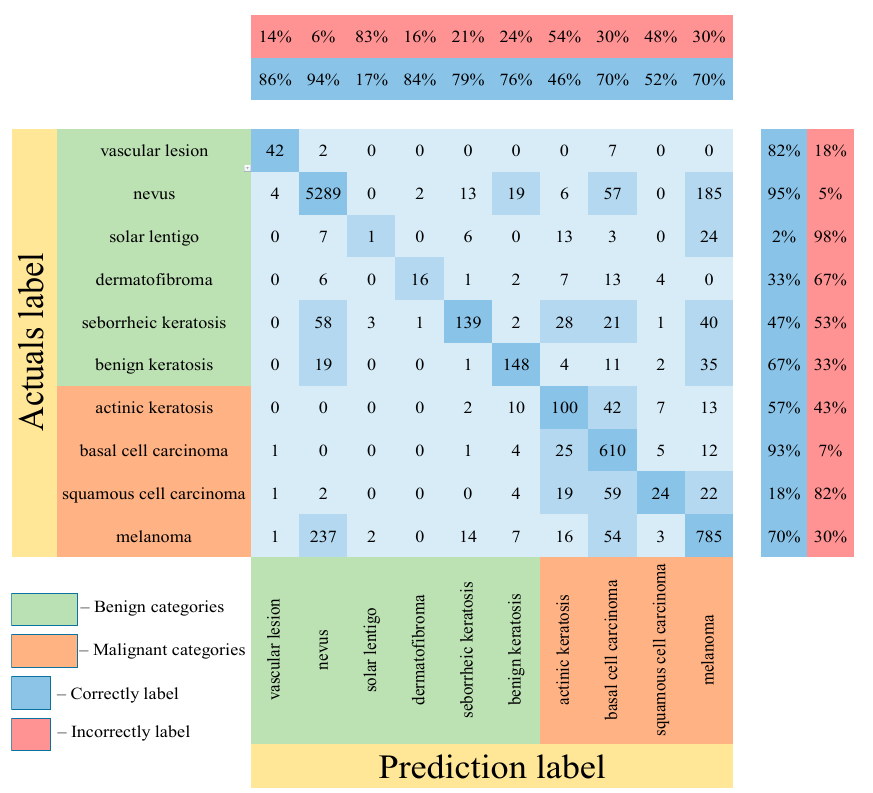
Figure 15. Confusion matrix in the testing results in a multimodal neural network system for recognizing pigmented skin lesions based on CNN ResNet ‐ 101.